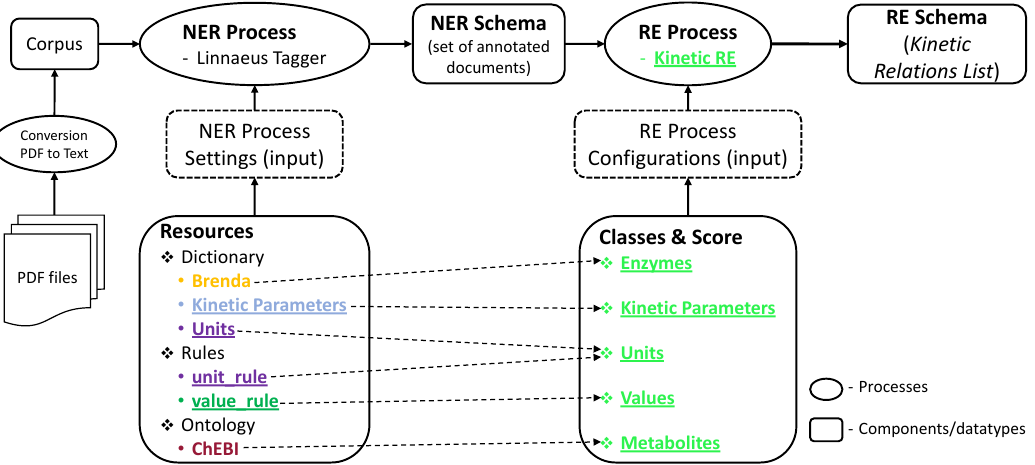
Figure 7: Main steps of the pipeline. Shown in light green and underlined are the new resources that were created in @Note2 in the scope of this